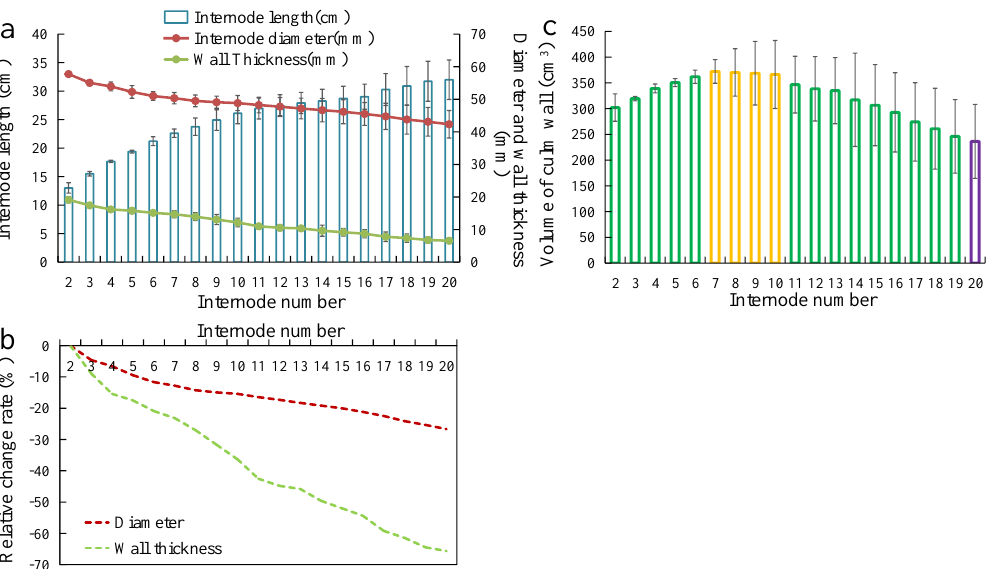
Figure 3. Variation pattern of bamboo culm morphology in the T. oliveri. ( a ) The length, diameter, and wall thickness of the internodes from the base 1st to 20th. ( b ) Relative change rate of the internode diameter and the wall thickness with the internode number. ( c ) Volume of culm wall of internodes from the base 1st to 20th. The green, yellow, and purple bars indicate significant differences among the three ( p < 0.05).